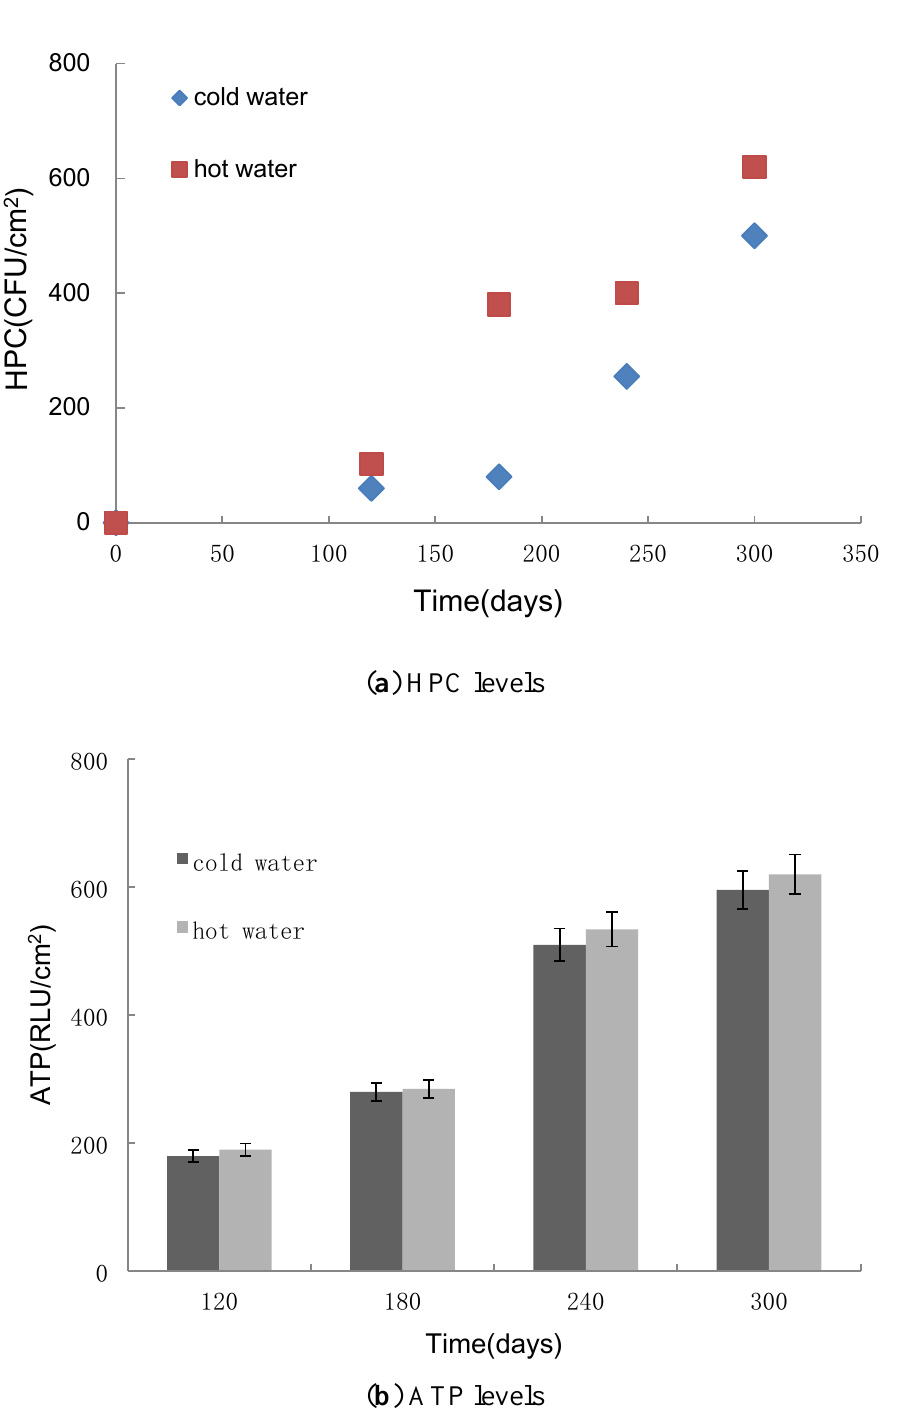
Figure 3. Variations in attached HPC and ATP levels on copper pipes per unit surface area in contact with both cold and hot water from a building-hold